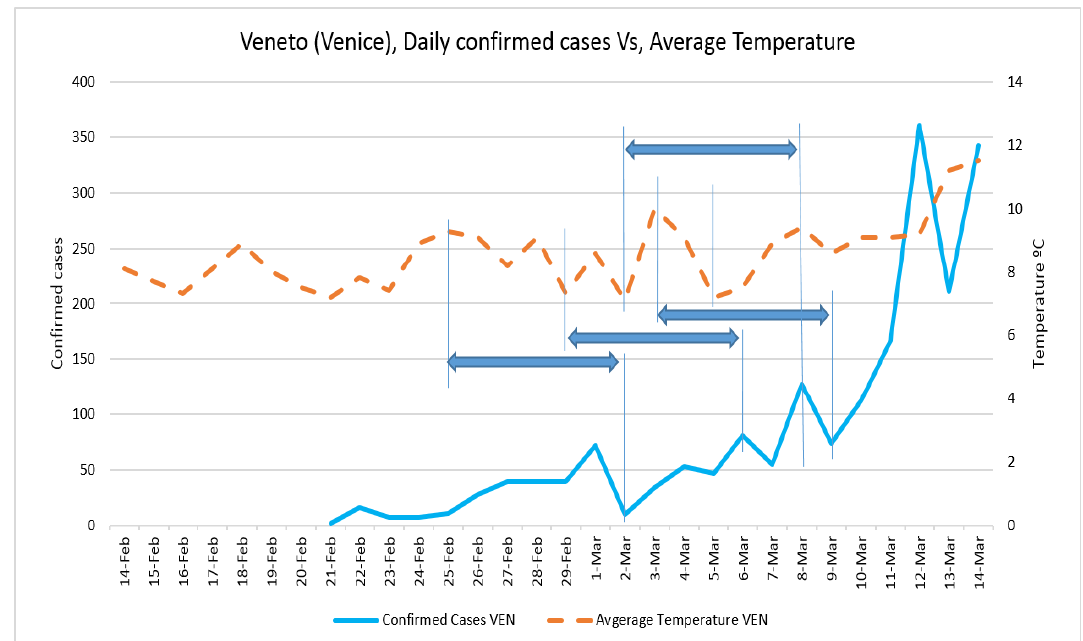
Figure 6. Daily confirmed cases of COVID-19 in Veneto and average temperature.